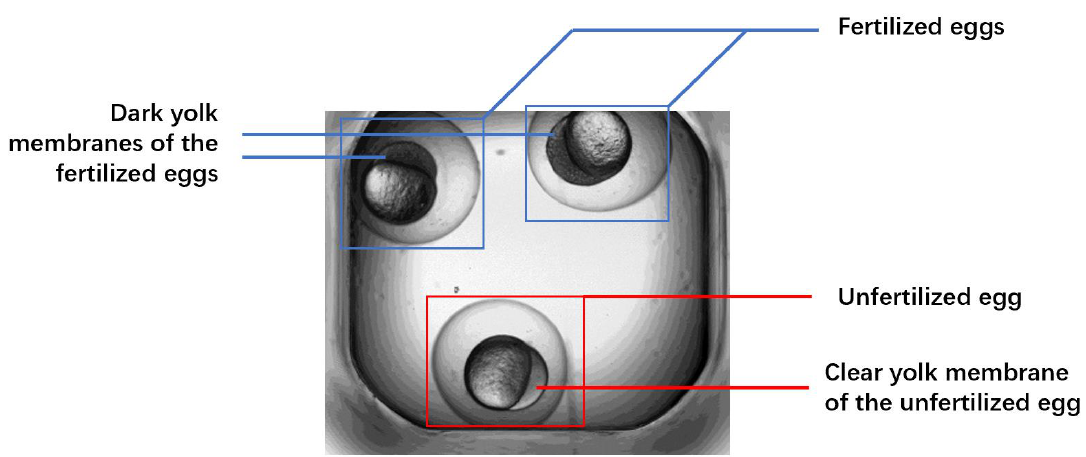
Figure 1. A typical example of the zebrafish eggs bright-field microscopic image, in which the fertilized and unfertilized eggs are marked. The fertilized eggs contain the nucleus surrounded by dark yolk membranes, whereas the unfertilized eggs have clear yolk membranes.